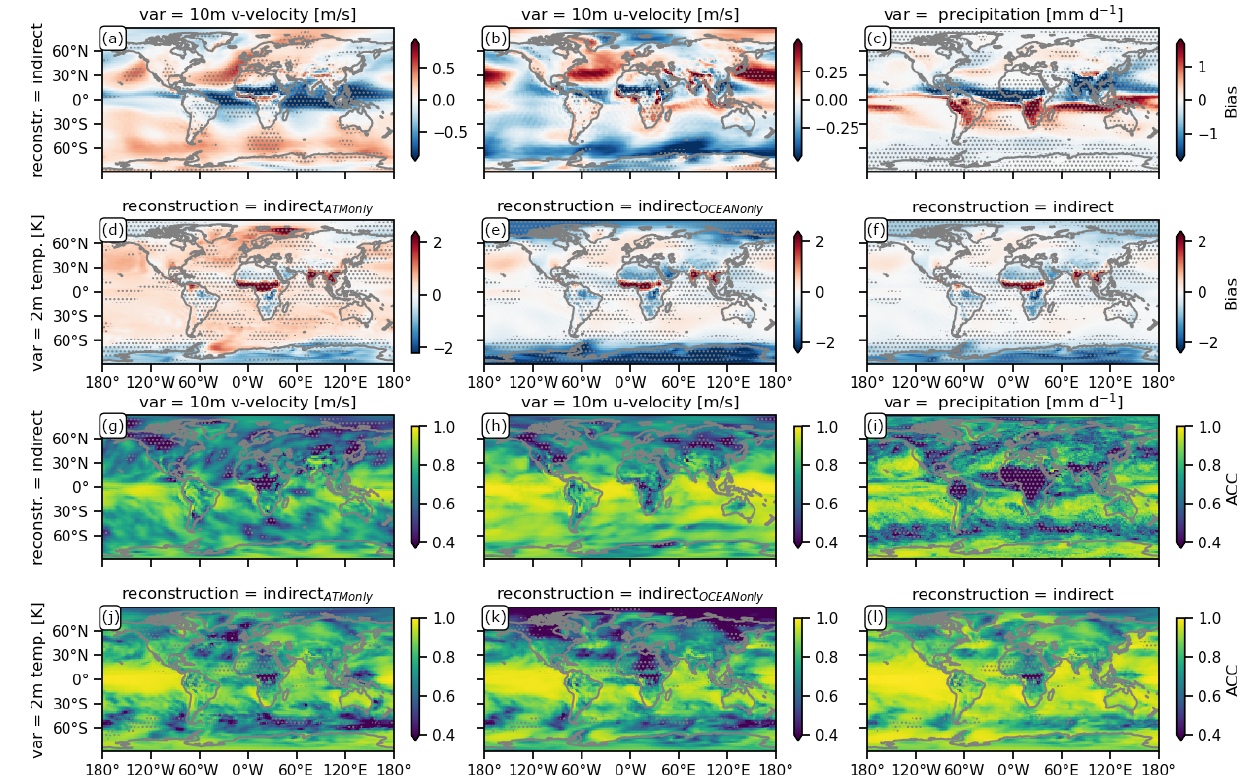
Figure 1. Spatial distribution of the bias (construction–target) (a–f) and anomaly correlation coefficient (ACC) (g–l) of different indirect carbon cycle reconstructions relative to the target over 10-year running windows of annual means (see Appendix A). The reconstruction metrics for 2m temperature are shown for the indirect ATMonly (d,j) , indirect OCEAN only (e,k) and indirect reconstruction (f,l) . Because of identical reconstruction skill for all indirect methods, only one indirect reconstruction is shown for other variables, zonal westward 10m wind (a,g) and meridional northward 10m wind (b,h) and precipitation (c,i) . Gray stippling shows where the metric exceeds the 5th- percentile (for a–f ) or 95th-percentile (for g–l ) threshold from random target block resampling, i.e., the reconstruction is not significantly better than internal